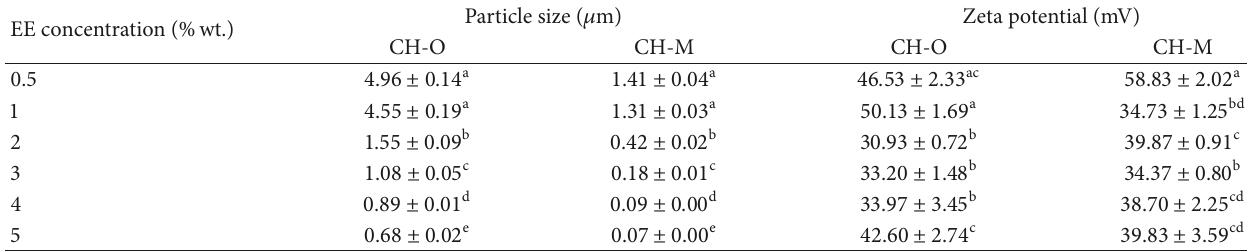
Table 2: Particle size and zeta potential of the oregano and marjoram chitosan based film-forming solutions. EE concentration